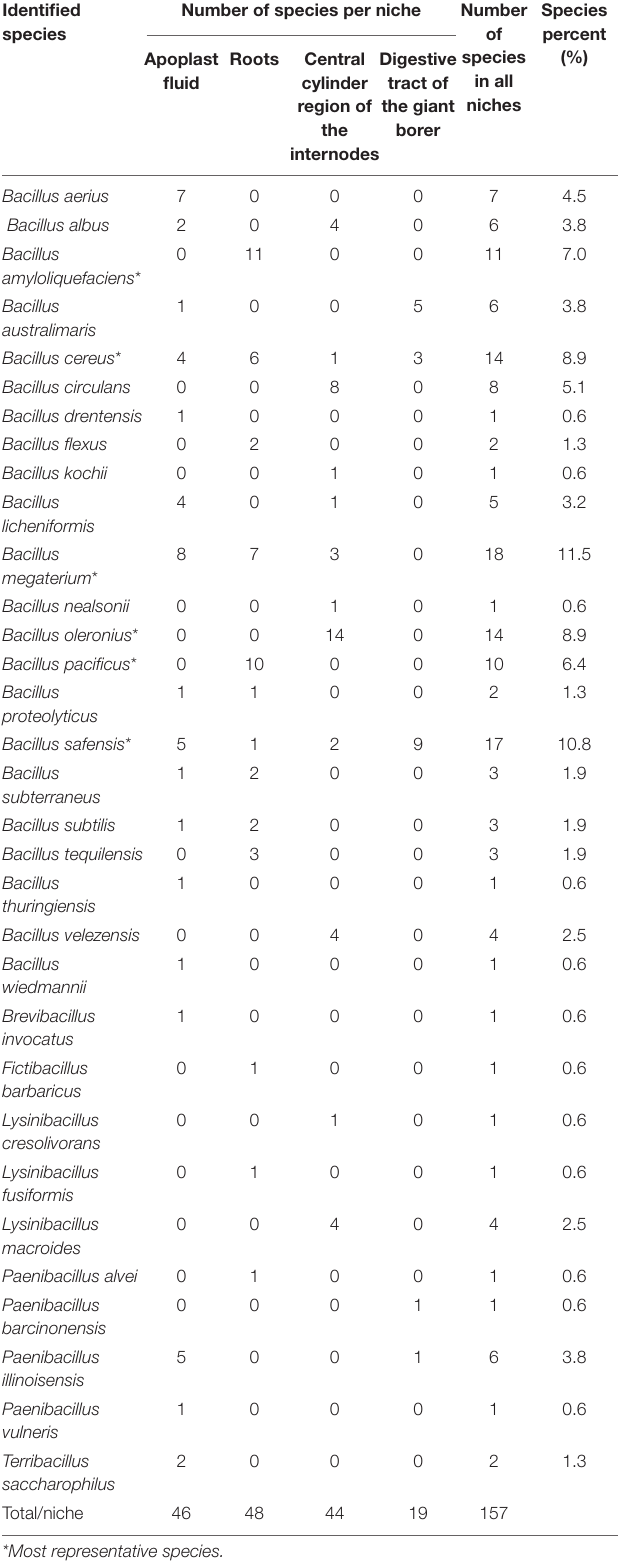
Number of species per niche Number